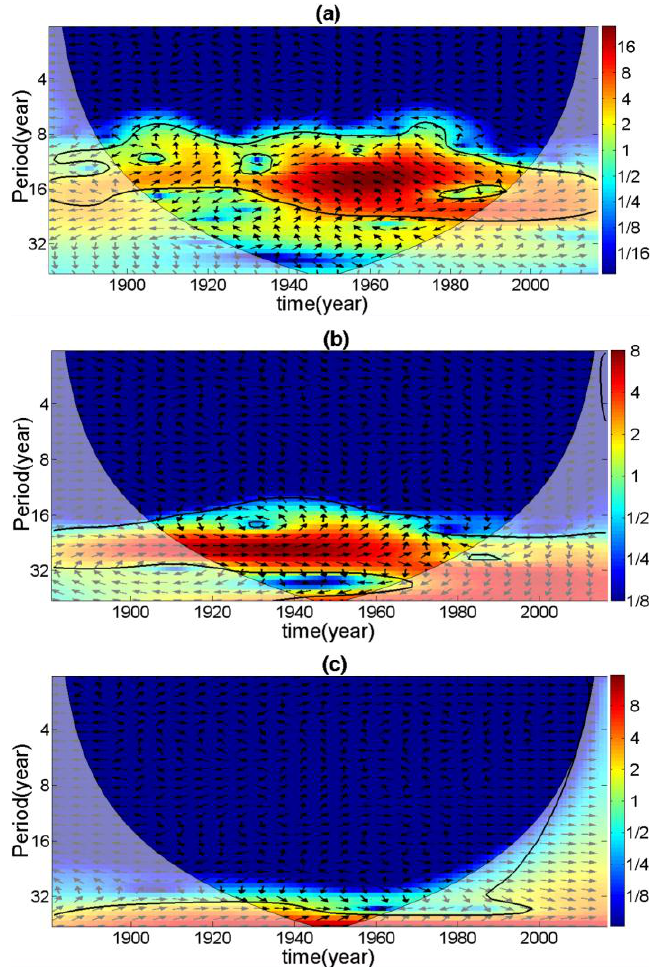
Figure 5. The cross wavelet of each intrinsic mode function (IMF): ( a ) the cross wavelet of IMF3; ( b ) the cross wavelet of IMF4; and ( c ) the cross wavelet of IMF5.